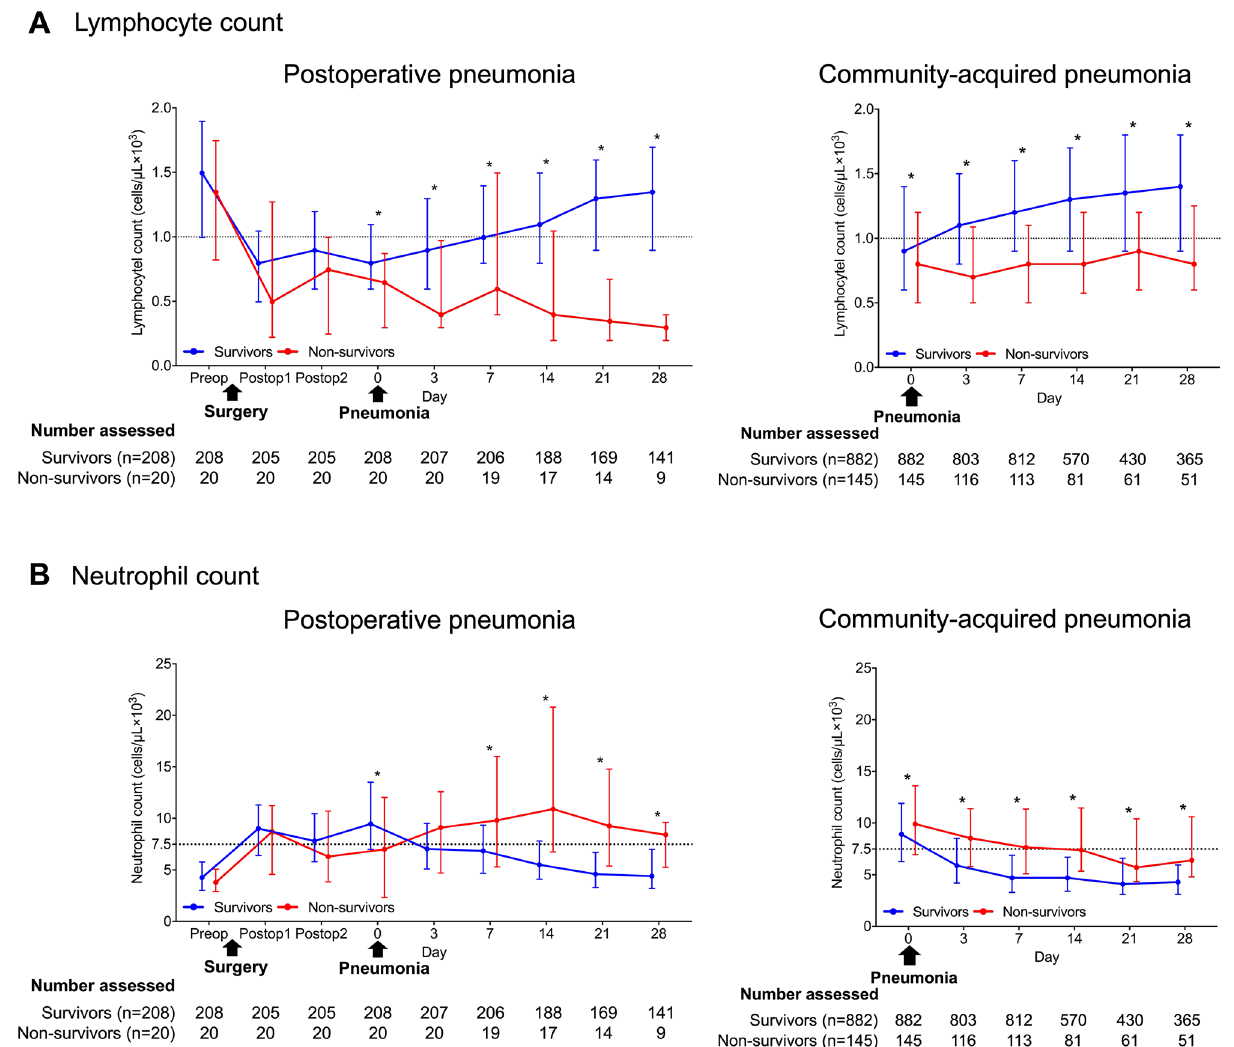
Figure 3. Time courses of absolute lymphocyte and neutrophil counts between survivors and non-survivors. Abbreviation: Preop = Preoperative day, Postop = Postoperative day.Time courses of absolute lymphocyte count (ALC) ( A ) and absolute neutrophil count (ANC) ( B ) between 90-day survivors and non-survivors in postoperative and community-acquired pneumonia are shown. Patients with community-acquired pneumonia included eligible patients without immunocompromised disorders (n = 1027). The dates of the preoperative laboratory test and the first and last postoperative laboratory test before pneumonia diagnosis are expressed as preoperative day, postoperative day 1, and postoperative day 2, respectively. The date of pneumonia diagnosis is described as day 0. The data at each time point are presented as the median and interquartile range. Dotted lines indicate the lower limit of the normal of ALC (1.0 × 10 3 cells/μL) and the upper limit of the normal of ANC (7.5 × 10 3 cells/μL). * P value < 0.05 for the comparison of cell counts between survivors and non-survivors at each time